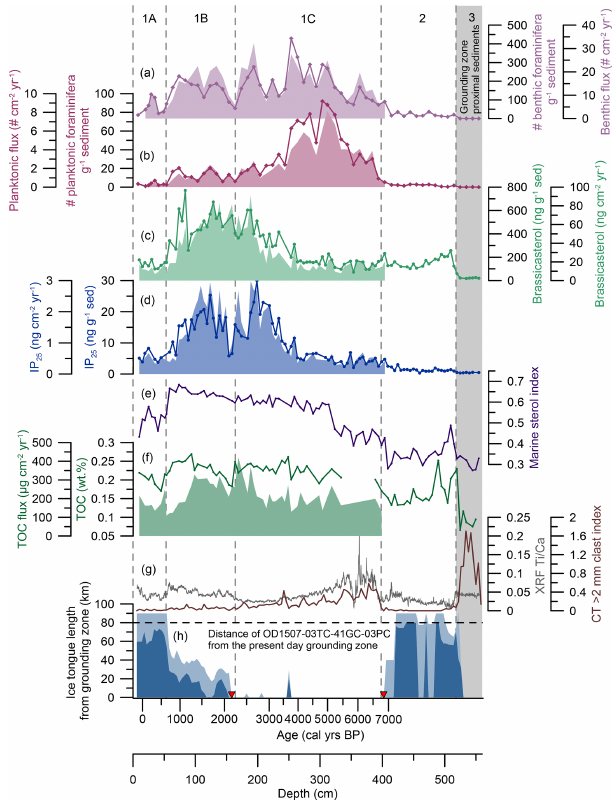
Figure 5. Temporal changes in the environmental conditions in Pe- termann Fjord. From the top to the bottom: (a) benthic foraminiferal fluxes (purple, filled-in area) and benthic foraminiferal abundance in individuals per gram of sediment (purple line with diamonds). (b) Planktonic foraminiferal fluxes (crimson, filled-in area) and planktonic foraminiferal abundance in individuals per gram of sediment (crimson line with diamonds). (c) Brassicasterol fluxes (light green, filled-in area) and absolute concentration (light green line with dots) normalized to the amount of extracted sediment (ngg − 1 sed). (d) IP 25 fluxes (blue, filled-in area) and absolute con- centration (blue line with dots) normalized to the amount of ex- tracted sediment (ngg − 1 sed). (e) Marine sterol index (sum of ma- rine sterols divided by the sum of all sterols) (purple line). (f) TOC fluxes (green, filled-in area) and TOC concentrations (wt%, green line). (g) XRF Ti / Ca ratios (grey) and the CT > 2mm clast index (brown) (Reilly et al., 2019). (h) Reconstruction of the Holocene ice tongue extent (minimum extent in dark blue, maximum extent in light blue) in Petermann Fjord in kilometers from the ground- ing zone (Reilly et al., 2019). OD1507-03TC-41GC-03PC is lo- cated 80km from the present-day grounding zone (black dashed line). Lithogenic units (1A–C, 2, 3) in sediment core OD1507- 03TC-41GC-03PC are indicated with dashed vertical lines; ground- ing zone proximal sedimentation (unit 3) is indicated with a grey vertical bar. The red triangles on the x axes indicate the timing of the ice tongue breakup ( ∼ 6900calyrBP) and the late Holocene in- ception of a small ice tongue ( ∼ 2200calyrBP) (Reilly et al.,